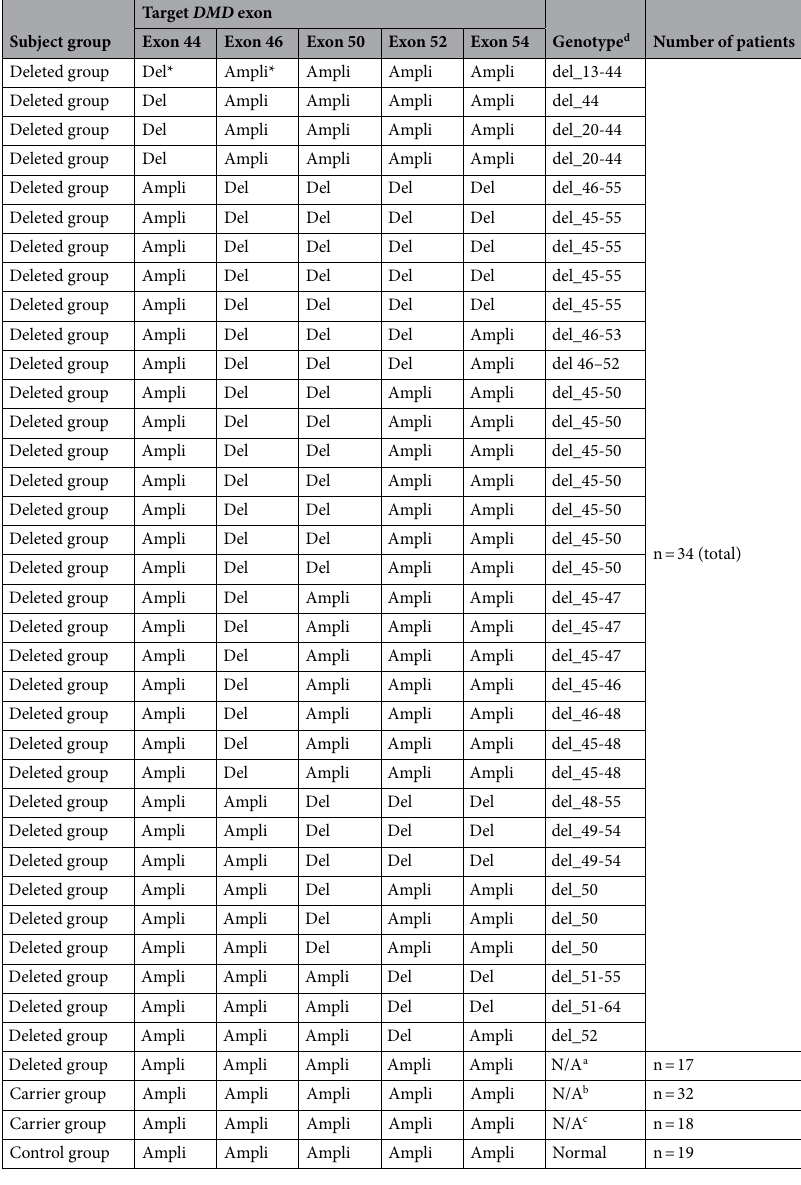
Table 2. Amplification results of the different subject groups: “deleted group”, “carrier group” and “control group”. a = male patients with a DMD deletion not overlapping any of the 5 target exons. b = female subjects carrying a DMD deletion overlapping at least one of the 5 target exons. c = female subjects carrying a DMD deletion not overlapping any of the 5 target exons. d = Deleted exons were identified through MLPA. Intronic breakpoints have not been sequenced; genotypes are reported according to the LOVD-DMD database. *Results show if the target exon is deleted (Del) or amplified (Ampli). N/A Not